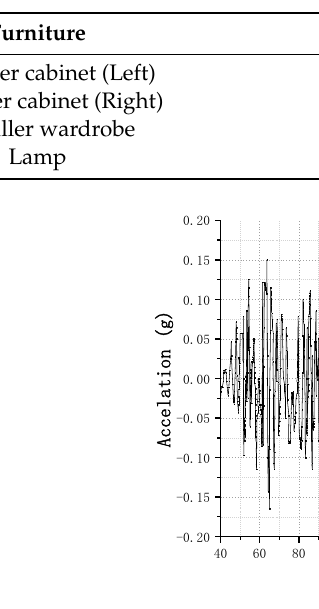
Figure 7. Recorded time-history data for the floor acceleration of the third story.